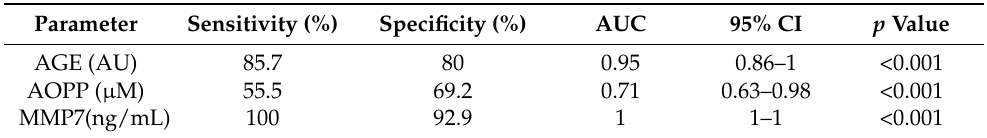
Table 3. ROC curves analysis to distinguish CTD-ILD from healthy participants. AGE: Advanced proteinase 7. AUC: Area under the curve.